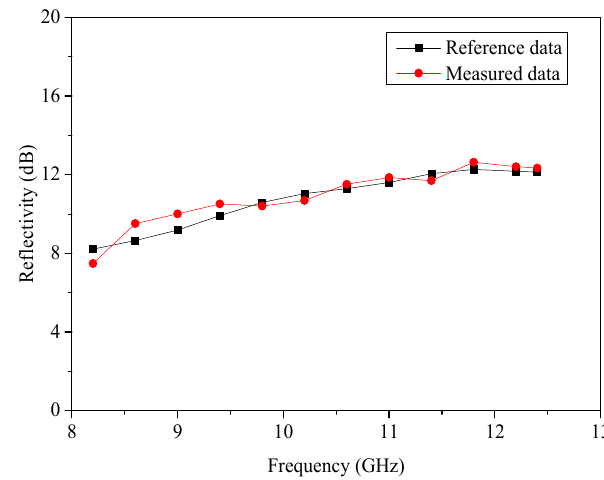
Figure 6. Experimental results of absorbing material coating #2.